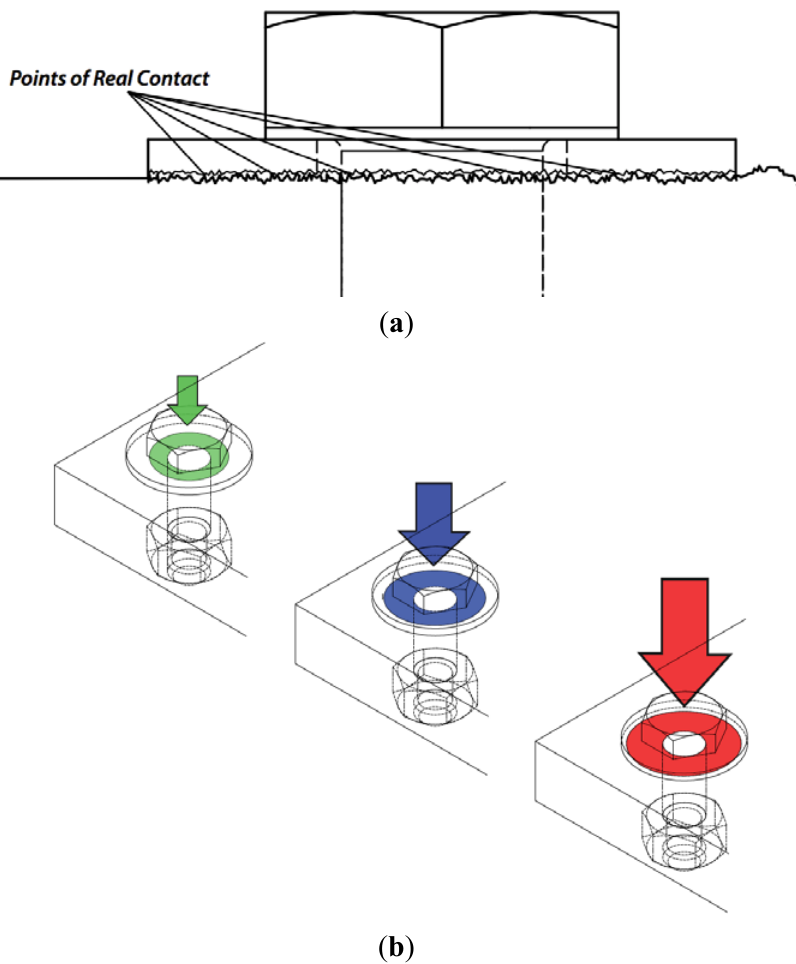
Figure 1. ( a ) Schematic representation of the real contact area of a clamped plate and washer; ( b ) schematic representation of change in the real area of contact as a function of increasing bolt